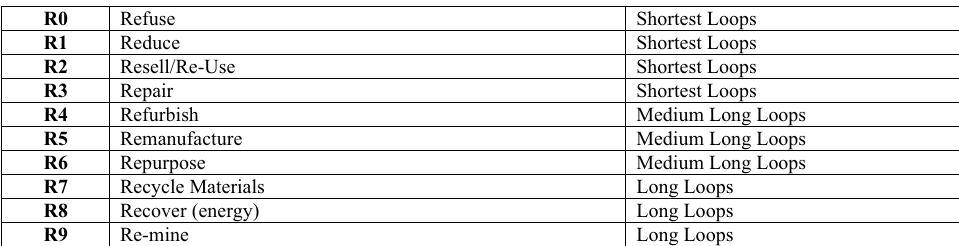
Table 3. The 10 Rs classified by loop types.